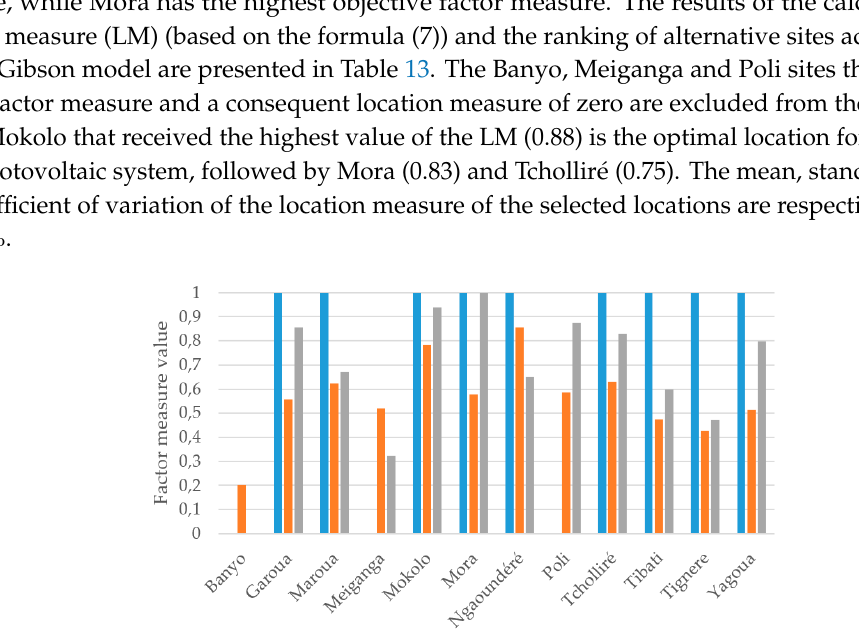
Table 13. Location measures and ranking of alternative sites.